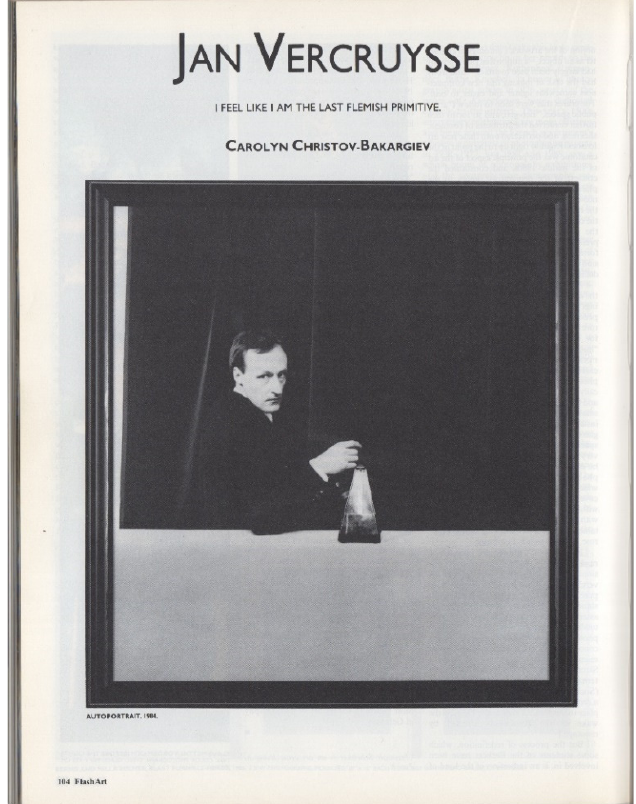
Figure 2. Title page of the interview of Jan Vercruysse with Carolyn Christov-Bakargiev, in Flash Art International (November 1989). Reprinted with permission from Jan Vercruysse